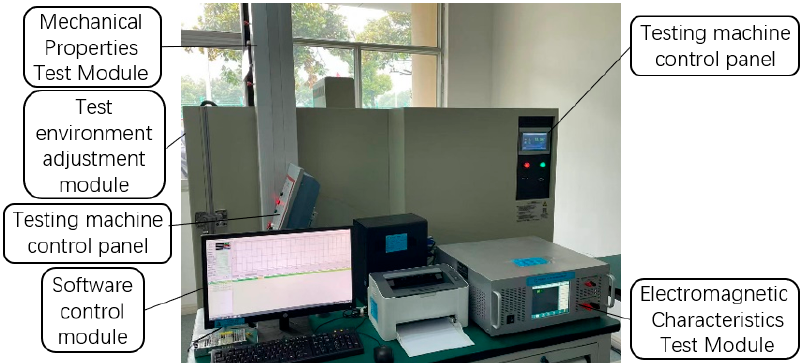
Figure 3. Multi-physics field coupled magnetic energy measurement system.